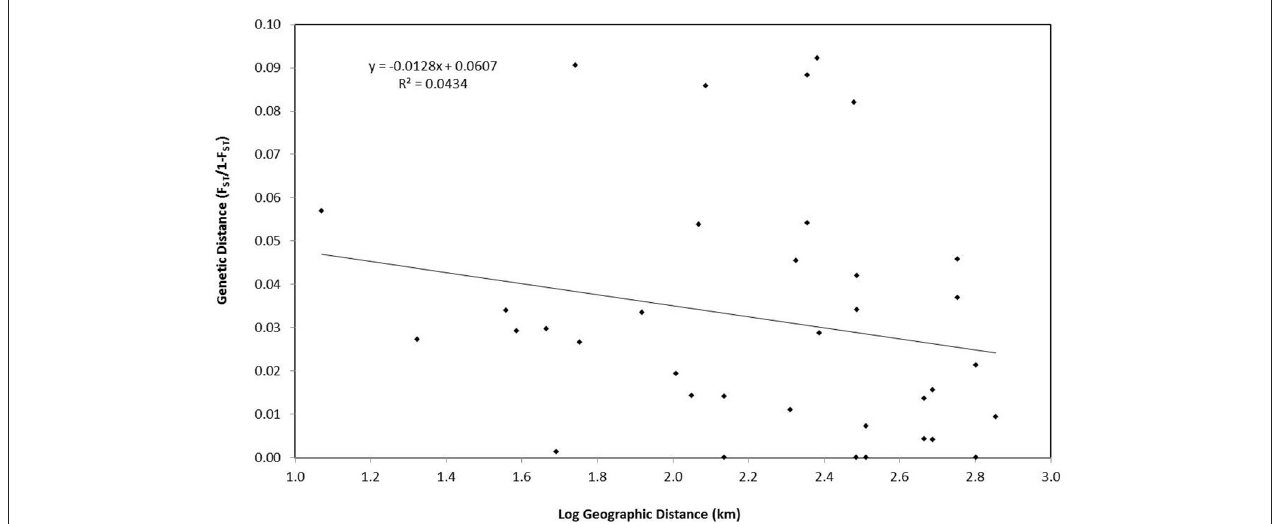
FIGURE 4 | Correlation between genetic distance and geographic distance for Nassau grouper.